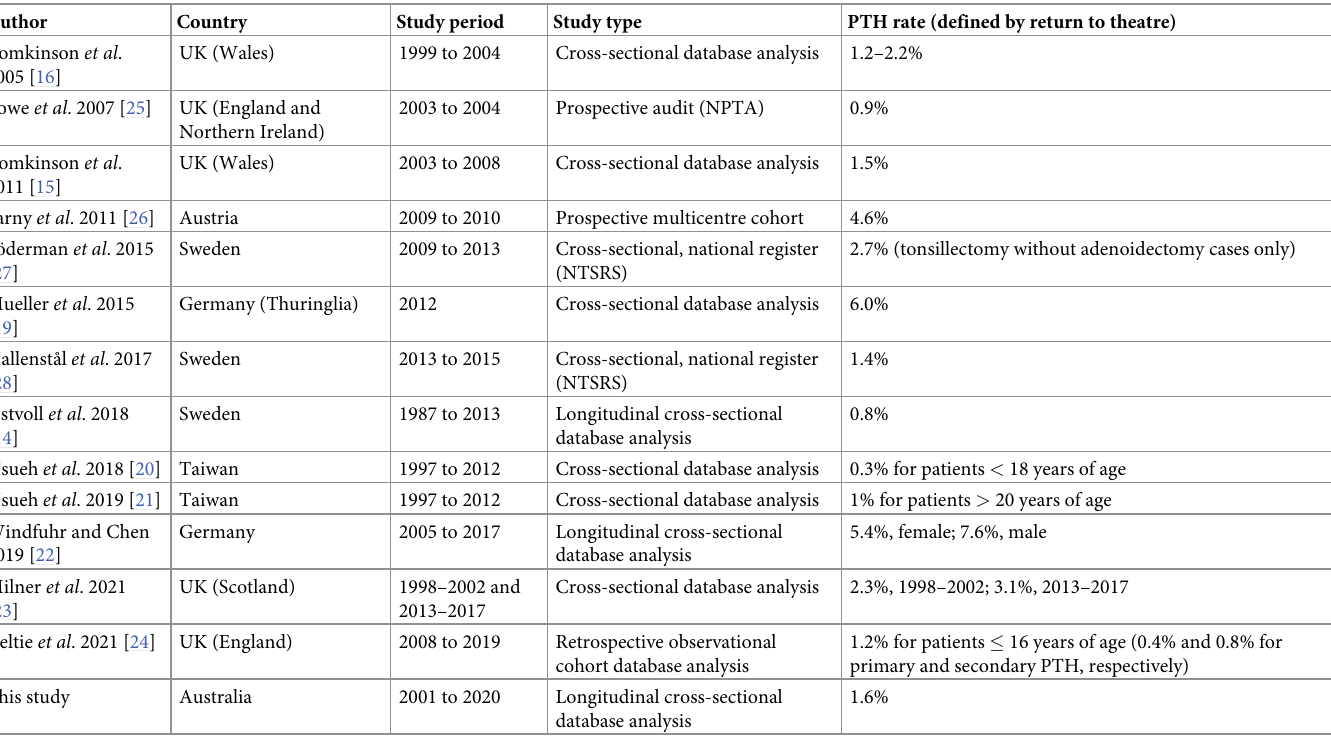
Table 4. Summary of population studies in the literature with reported post-tonsillectomy haemorrhage rates defined by rates of return to